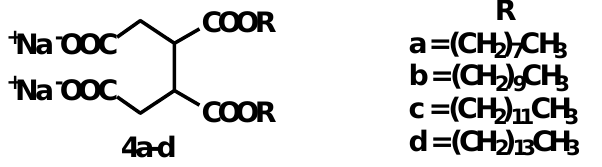
Figure 1. Disodium 2,3-dialkyl-1,2,3,4-butanetetracarboxylates 4a–d